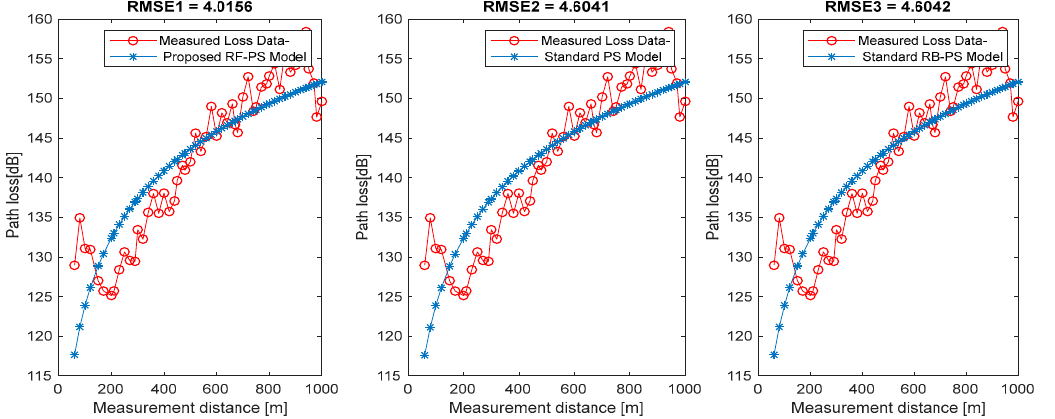
Figure 17. Results showing the measured path loss versus distance using the hybrid RF-PS method and two existing standard path loss prediction methods in site 1 of location 4.